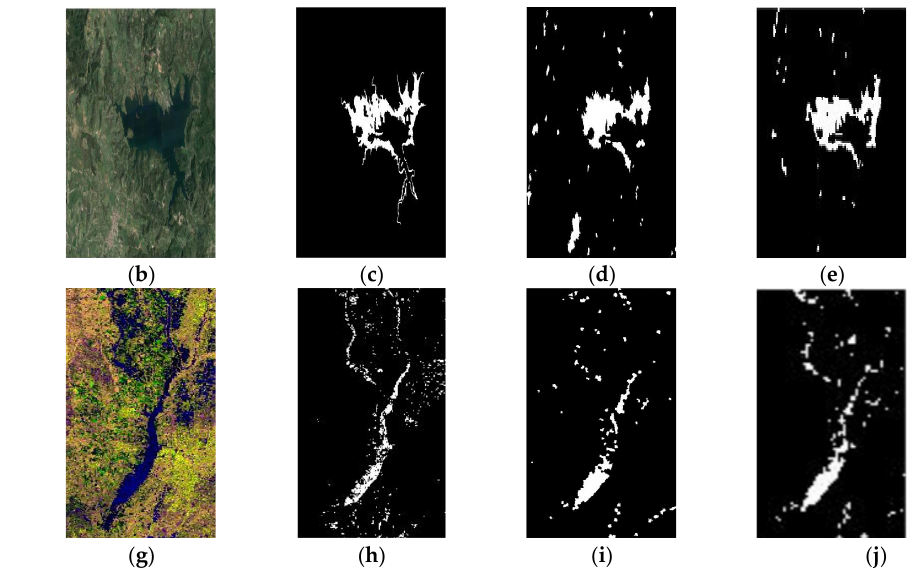
Figure 4. Performance comparison: ( a ) pre-event of Italy; ( b ) after-event of Italy; ( c ) ground truth of Italy; ( d ) our proposed method with modification of Italy; ( e ) our proposed method of Italy; ( f ) pre-event of California; ( g ) after-event of California; ( h ) ground truth of California; ( i ) our proposed method with modification of California; ( j ) our proposed method of California. Table 5. The performance comparison for Italy to show the role of feature classification part.